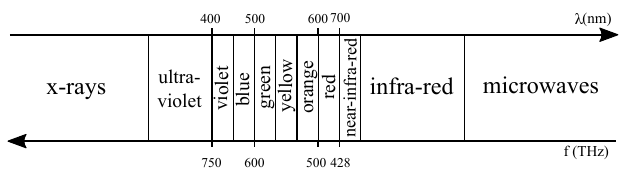
Figure 1. Visible electromagnetic spectrum.